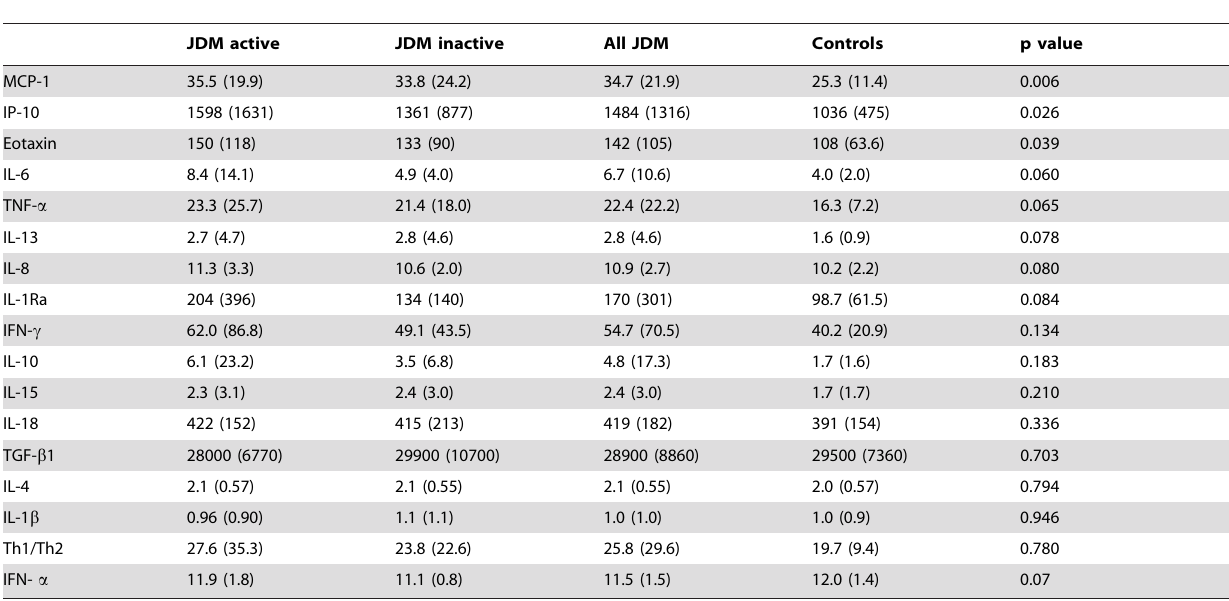
Table 2. Cytokine levels in patients with juvenile dermatomyositis assessed median 16.8 years after disease onset, and in